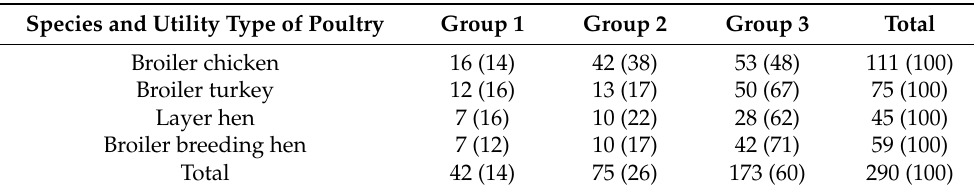
Table 2. Severity of anatomopathological lesions (divided into groups) in the course of colibacillosis in species and utility types of poultry— n